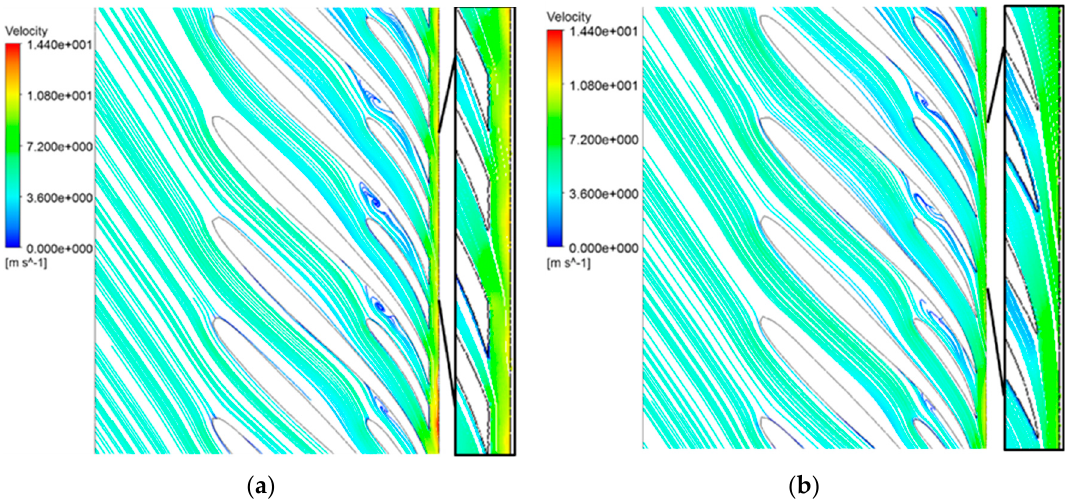
Figure 12. Velocity streamlines of ( a ) the prototype; ( b ) Model C.